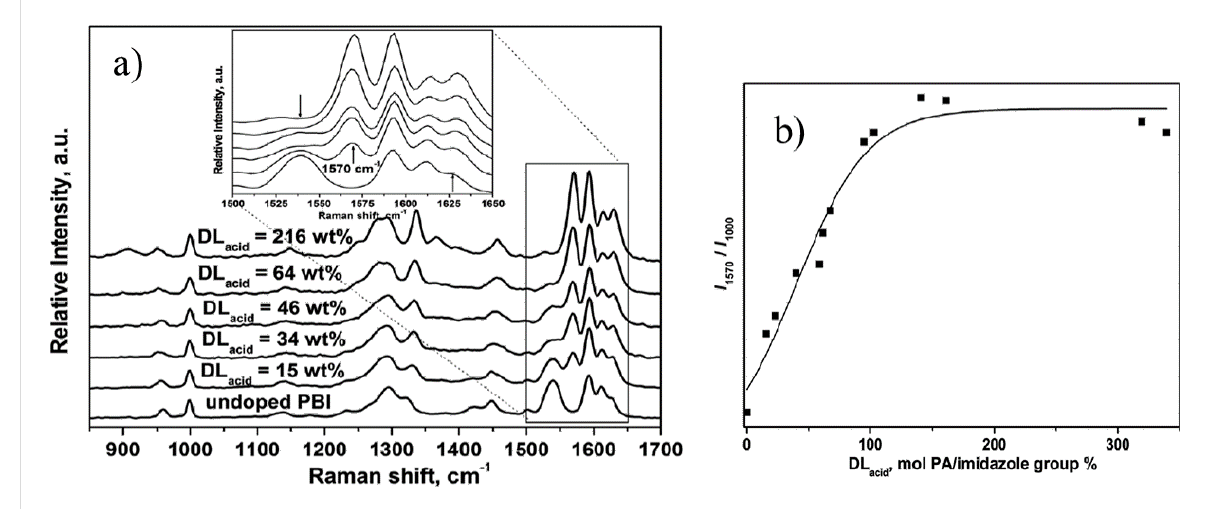
Figure 9: (a) Raman spectra of pristine and phosphoric acid-doped PBI. (b) Ratio of relative intensities versus acid doping level expressed in 1 M H 3 PO 4 per polar group (%) for the peaks 1570 and 1000 cm − 1 for PBI/ H 3 PO 4 . Reproduced with permission from [55]. Copyright 2014 Royal Society of Chemistry.